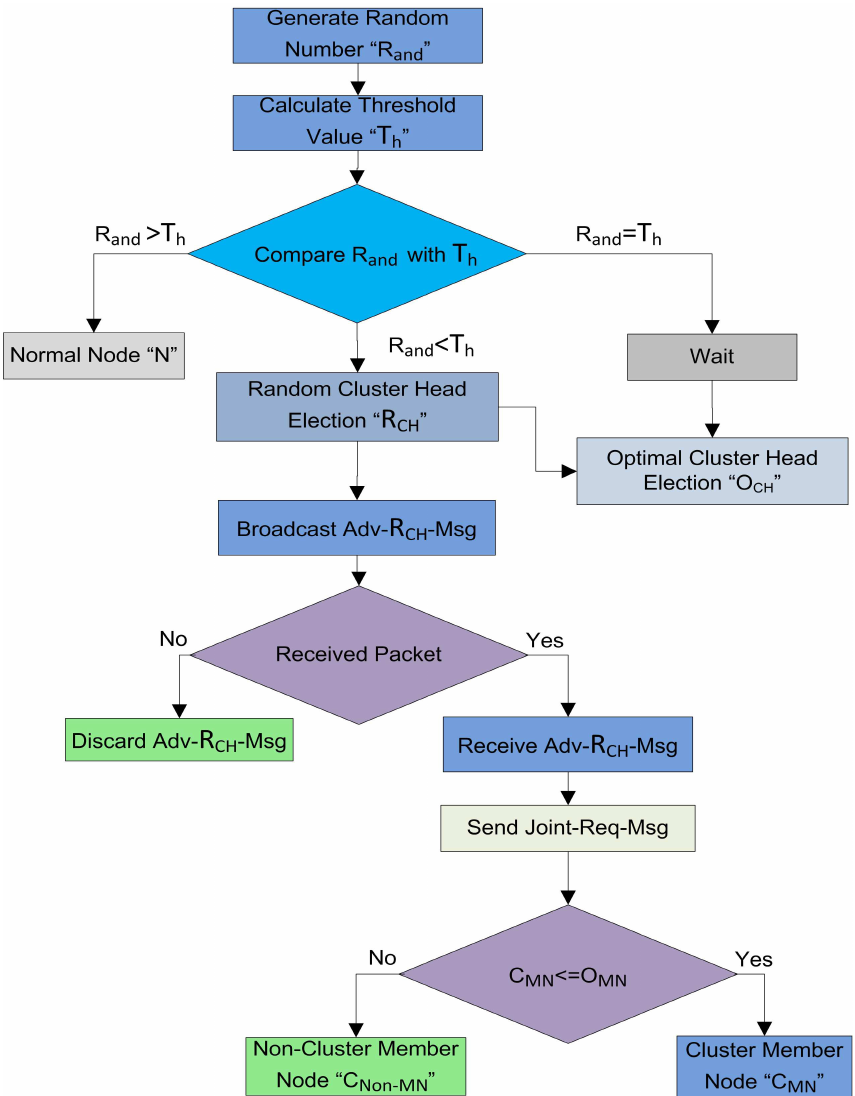
Figure 4. The random election, random Cluster Head (CH) selection, and random cluster formation in the